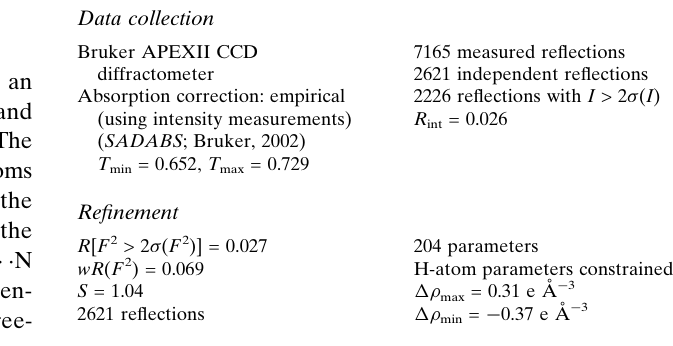
Data collection Bruker APEXII CCD diffractometer Absorption correction: empirical (using intensity measurements)